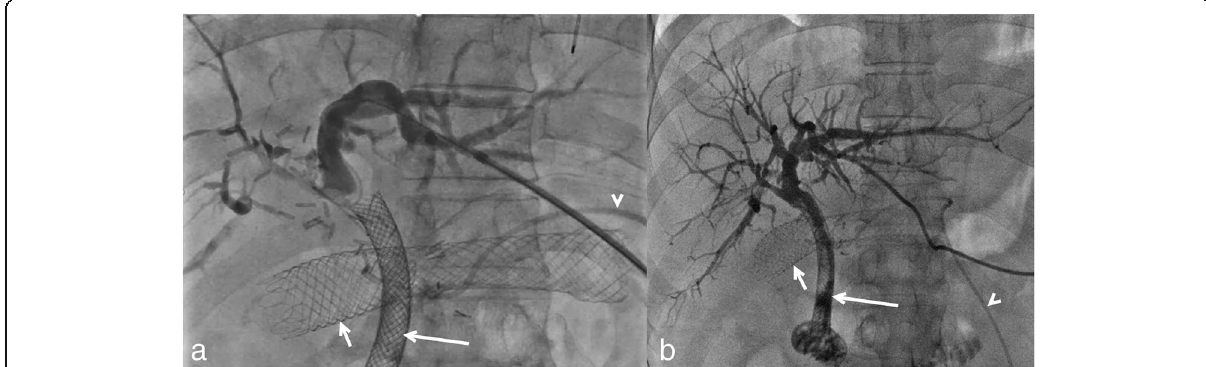
Fig. 1 Initial cholangiogram during left IEBD catheter placement. The CBD stent (long arrow) is obstructed ( a ). There was no isolation of ducts ( b ). The proximal duodenal stent (short arrow) and catheter of HAIP (arrowhead) are